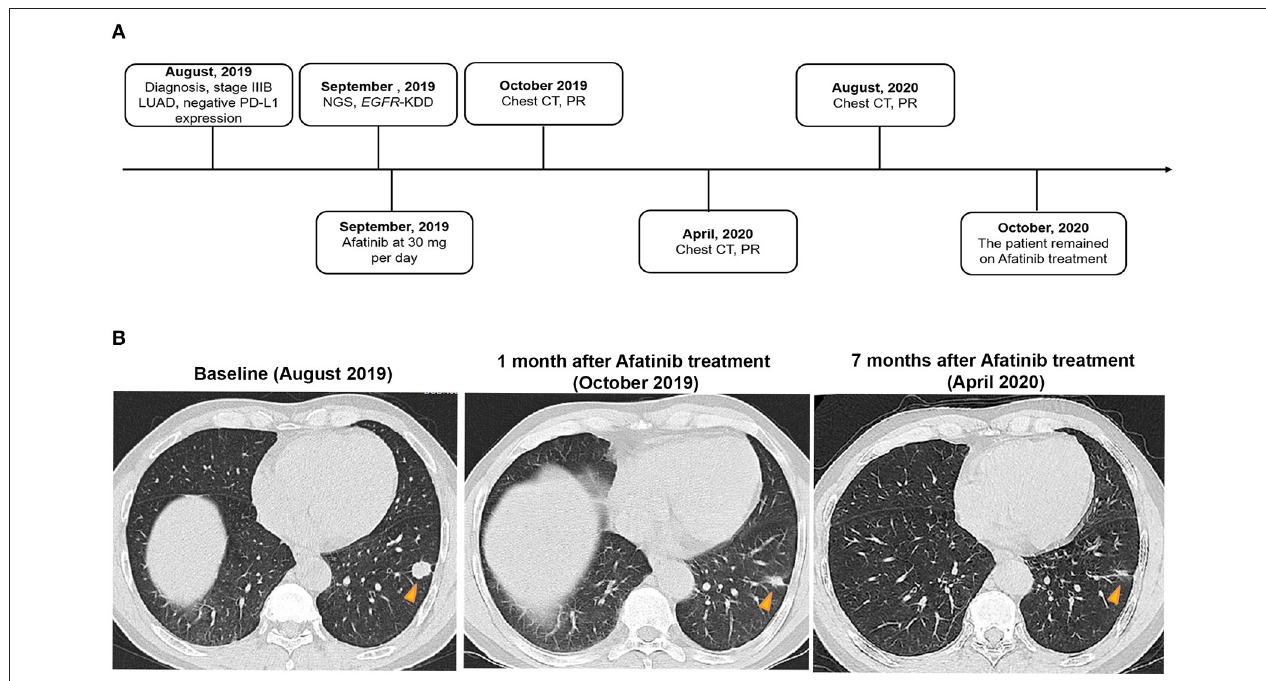
FIGURE 2 | A summary of the treatment procedure of the patient. (A) The entire treatment procedure. LUAD, lung adenocarcinoma; PR, partial response; NGS, next-generation sequencing; EGFR , human epidermal growth factor receptor 2; KDD, kinase domain duplication; CT, computed tomography; PD-L1, programmed death ligand-1. (B) Chest CT imaging of the LUAD patient prior to afatinib treatment, 1 month after the treatment, and 7 months after the treatment. The yellow arrows indicate the lesions. LUAD, lung adenocarcinoma; CT, computed